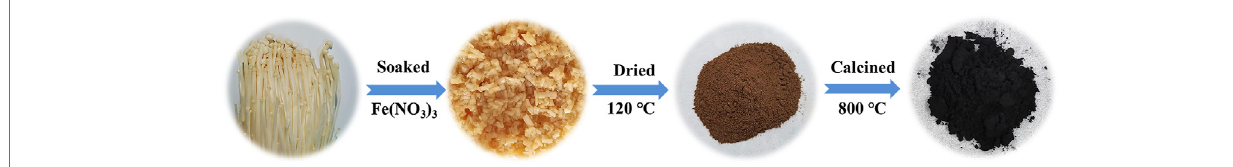
FIGURE 1 | Scheme of the synthesis process of Fe-EMC.